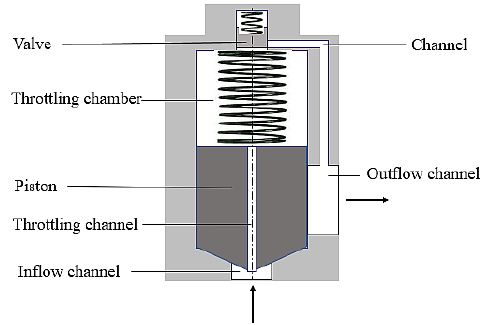
Figure 1. Electromagnetic